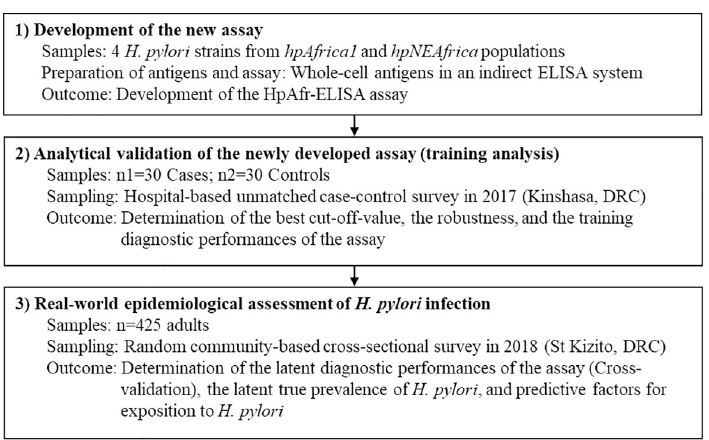
Fig 1. Flowchart for the study methodology. This study followed three main steps including the development of the new ELISA assay followed by its analytical validation using a training set of clinical samples (Cases and Controls), and, finally, its implementation during a real-world epidemiological